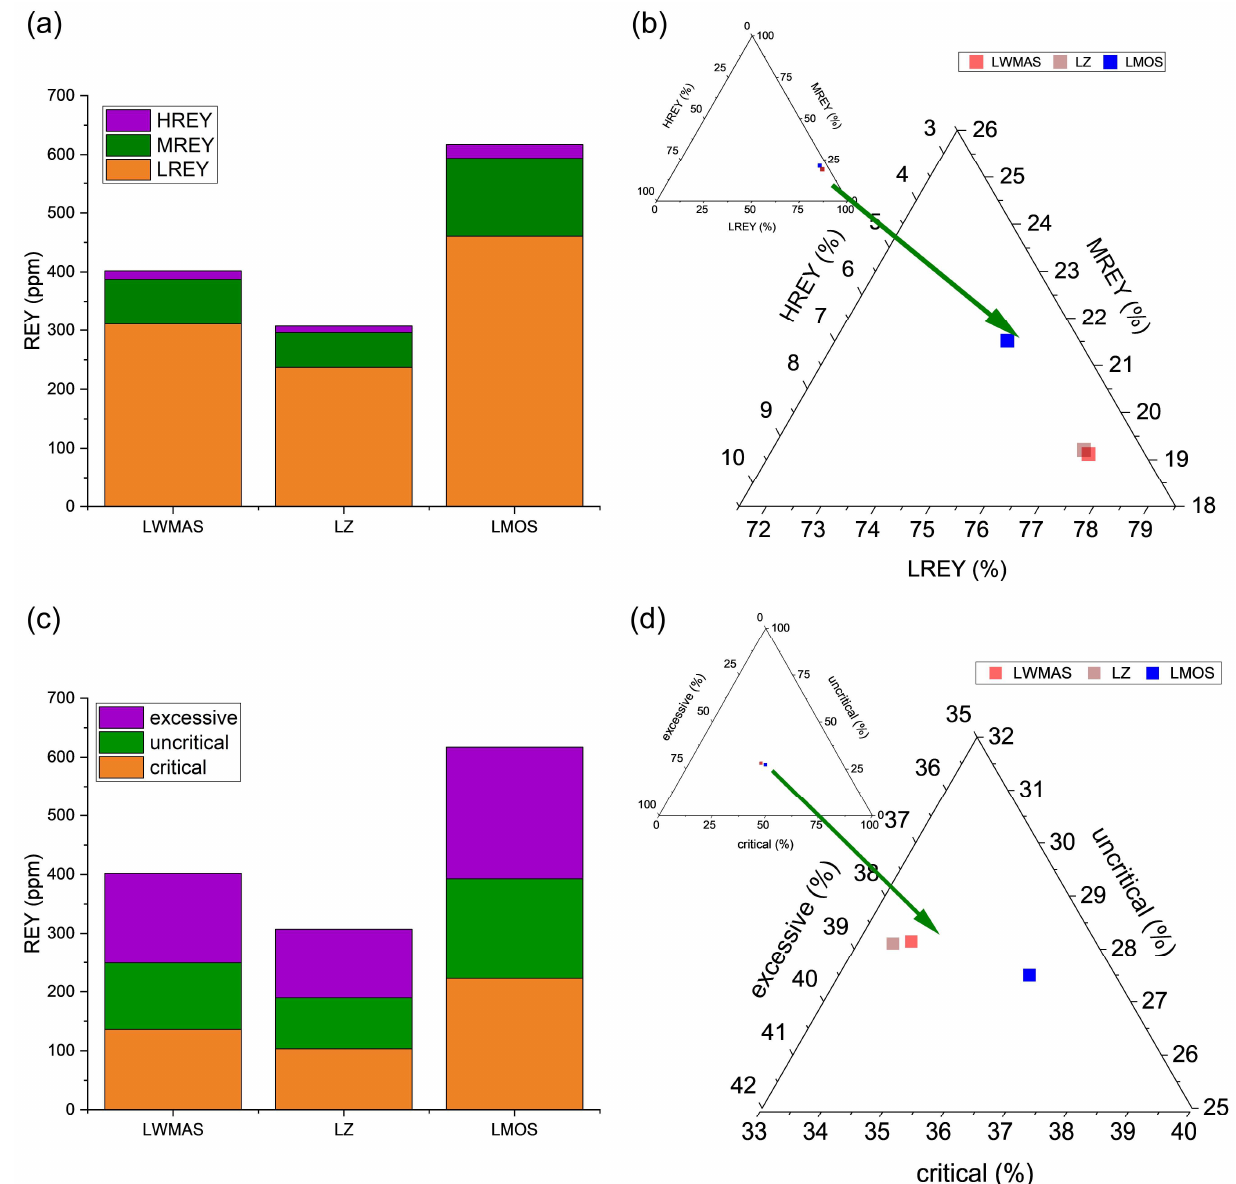
Figure 7. REY distribution in the tested ashes LWMAS, LZ, and LMOS: ( a ) content of HREY, MREY, and LREY; ( b ) percentage share of HREY, MREY, and LREY; ( c ) content of critical, uncritical, and excessive elements; ( d ) percentage share of uncritical and excessive elements.